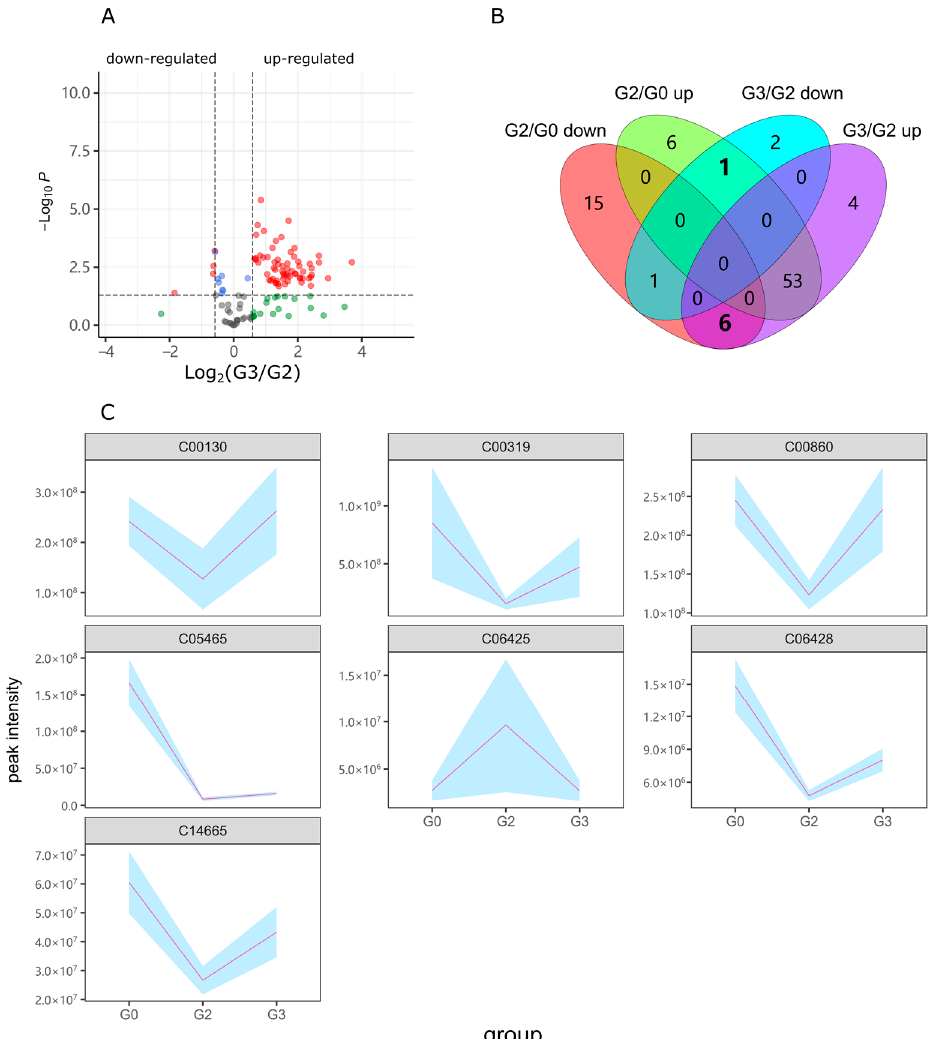
Figure 5. Differential metabolites induced by puerarin. ( A ) Volcano plot of the contrast between G3 and G2. ( B ) Number of changed metabolites compared with G2/G0. ( C ) Response metabolites with reverse changing trends when zebrafish were exposed to alcohol and puerarin. The light blue background represents the standard deviation range. Statistical p < 0.05; Fold Change > 1.5; G2/G0, G2 vs. G0; G3/G2, G3 vs. G2.